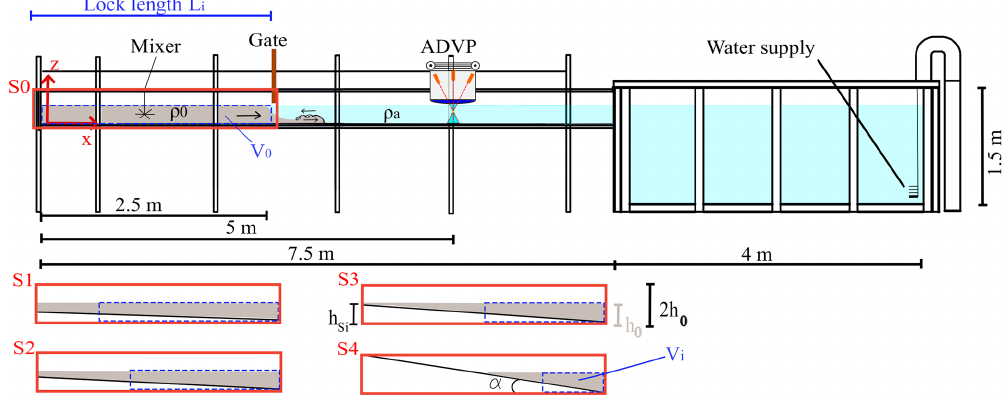
Figure 1. Longitudinal view and cross section of the experimental setup showing tested slope configurations S0 to S4 of lock volumes V i